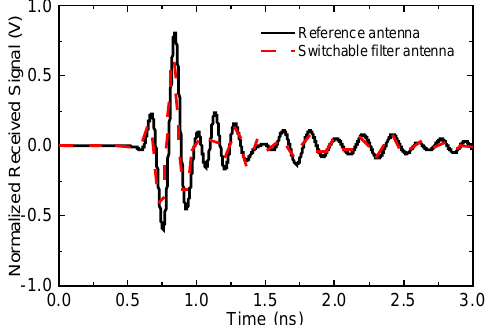
Figure 7. Normalized received signal waveform of reference and switchable antennas.